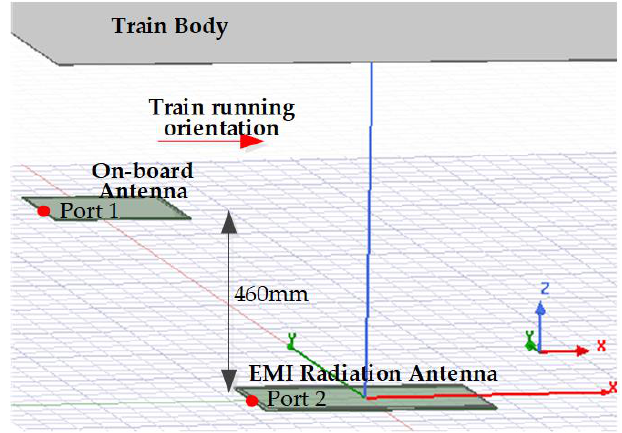
Figure 10. Numerical simulation model for radiation disturbance coupling.